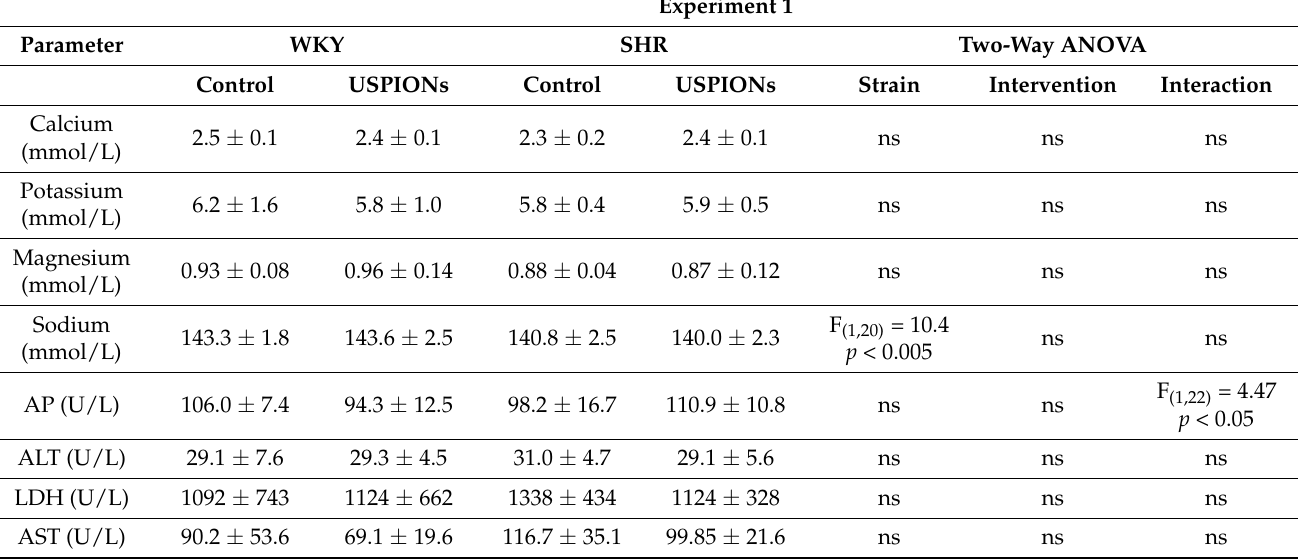
Table 1. Biochemical parameters were determined in plasma after a single administration of USPIONs at the dose of 1 mg Fe/kg of body weight. Rats were killed approximately 100 min after the USPION administration. Abbreviations: USPIONs, ultra-small superparamagnetic iron-oxide nanoparticles; WKY, Wistar Kyoto rats; SHR, spontaneously hypertensive rats; AP, alkaline phosphatase; ALT, alanine aminotransferase; LDH, lactate dehydrogenase; AST, aspartate aminotransferase; P, phosphate. Results are presented as mean ± SD. * p < 0.0001 vs. WKY control; + p < 0.0001 vs. WKY